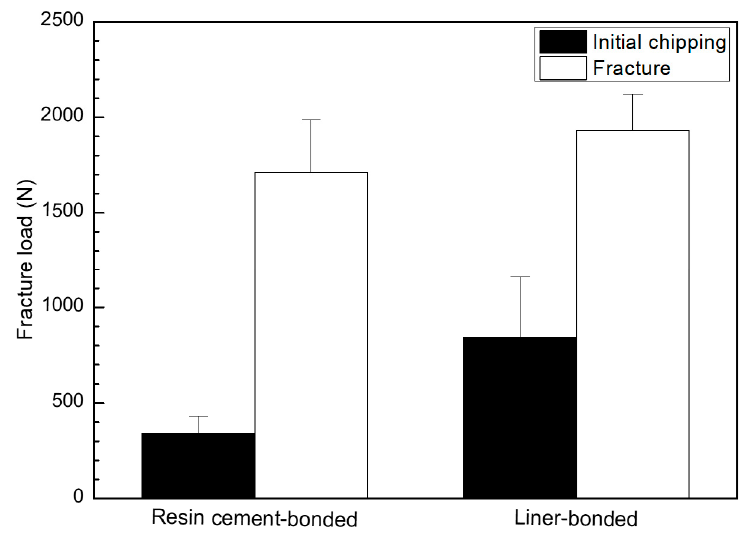
Figure 8. Graphical illustration for initial chipping and fracture strengths of crowns for the resin cement-bonded and liner-bonded groups.